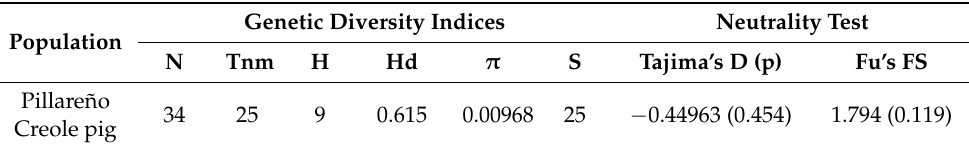
Table 2. Genetic diversity indices for Pillareño Creole pig population. Genetic Diversity Indices Neutrality Test Population N Tnm H Hd π